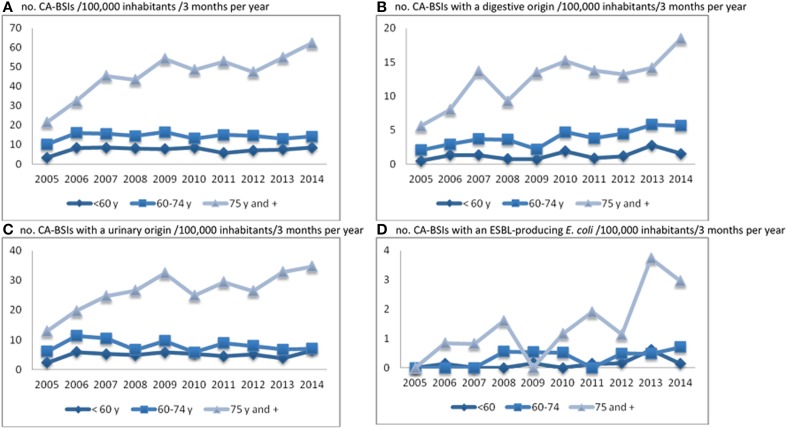
Trends in CA-BSI incidence (no. of cases/100,000 inhabitants/3 months per year) by age group (A), by origin of BSI (B and C) and for BSIs with ESBL-producing
E. coli
isolates (D).